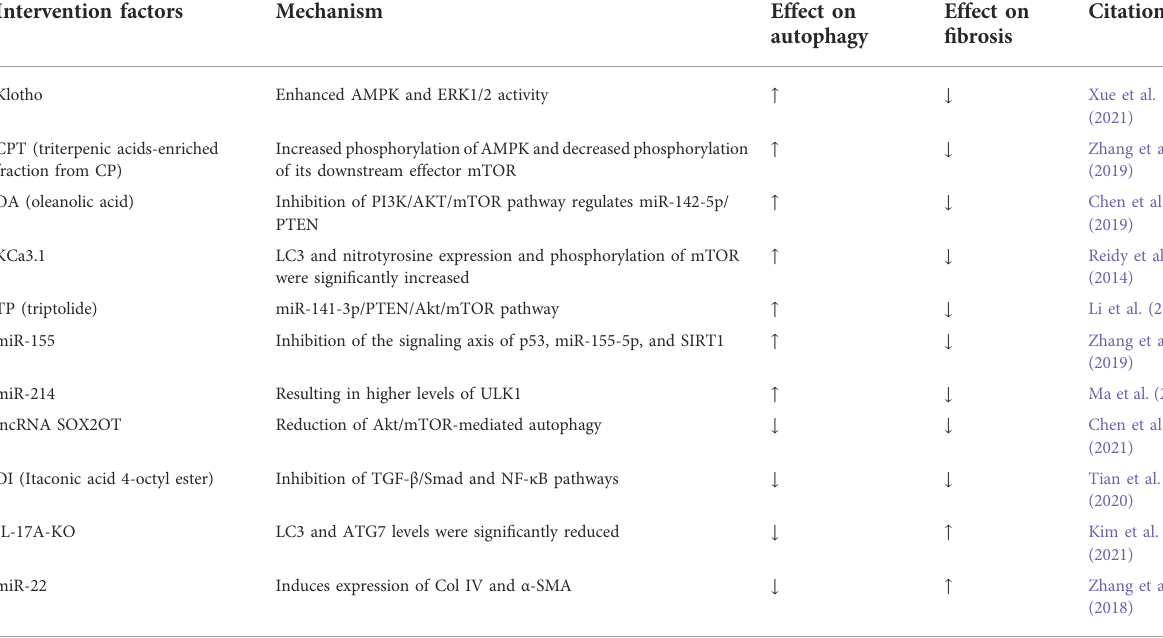
TABLE 3 Dual regulation of autophagy in diabetic kidney disease model. Intervention